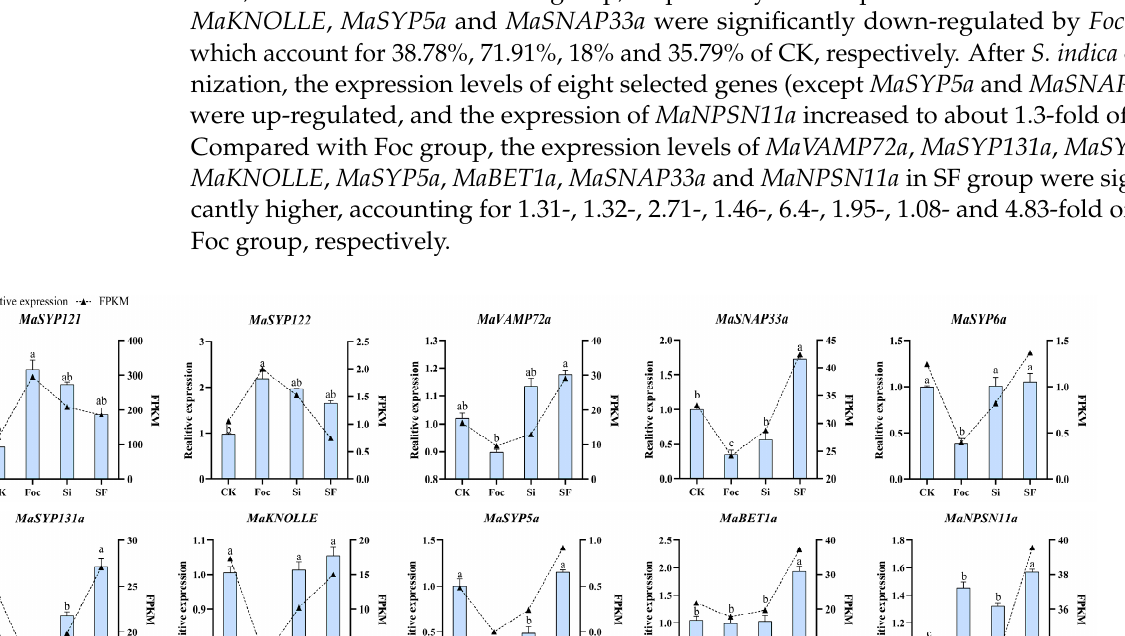
Figure 8. qRT-PCR analysis results of 10 selected MaSNARE s. Different lowercase letters above the columns represent significant differences at p < 0.05 level.